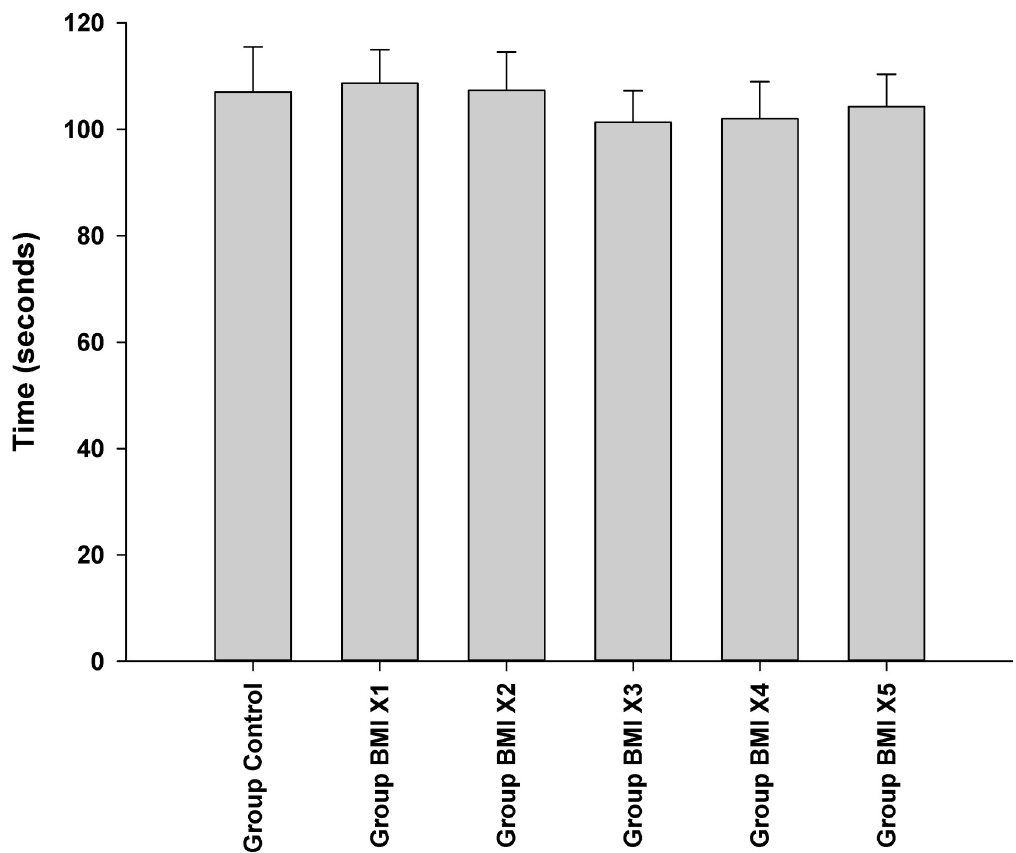
Fig 6. Motor function tests. The graphs are presented as means ± standard deviation of the time at which the rat fell off the Rota-Rod.